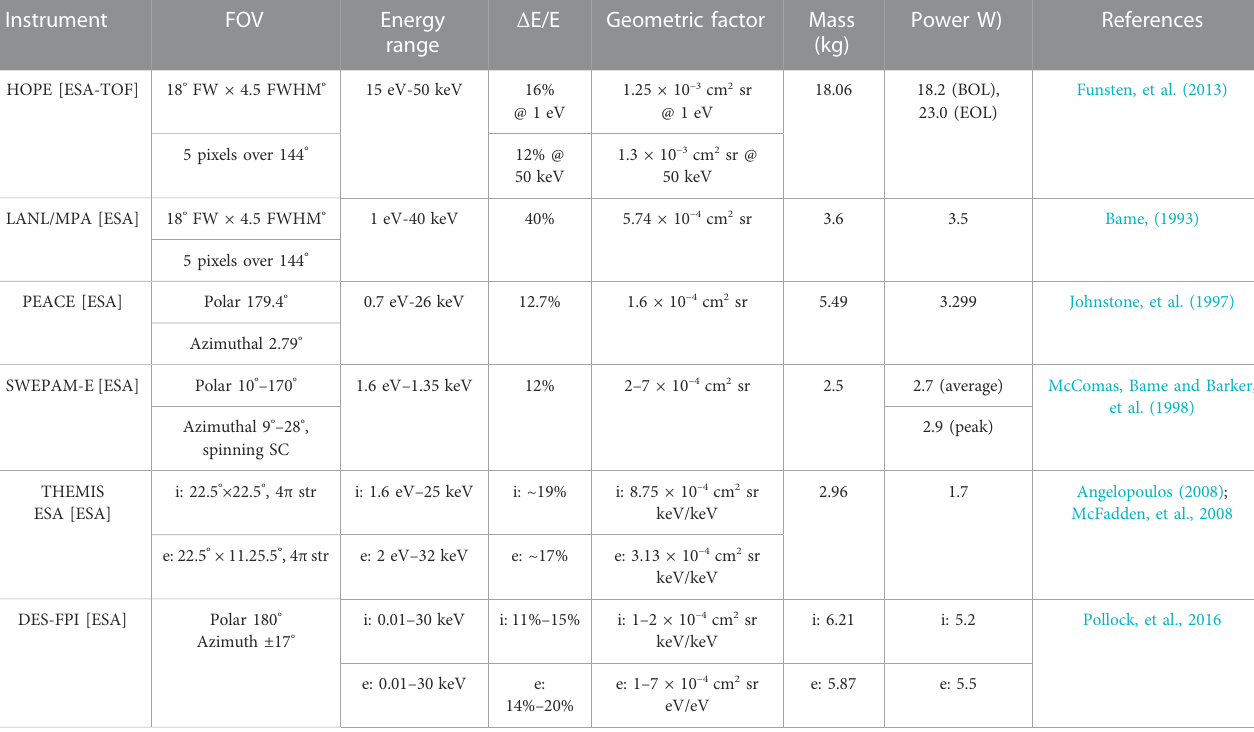
TABLE 2 Performance speci fi cations for representative state-of-the-art electron spectrometers.